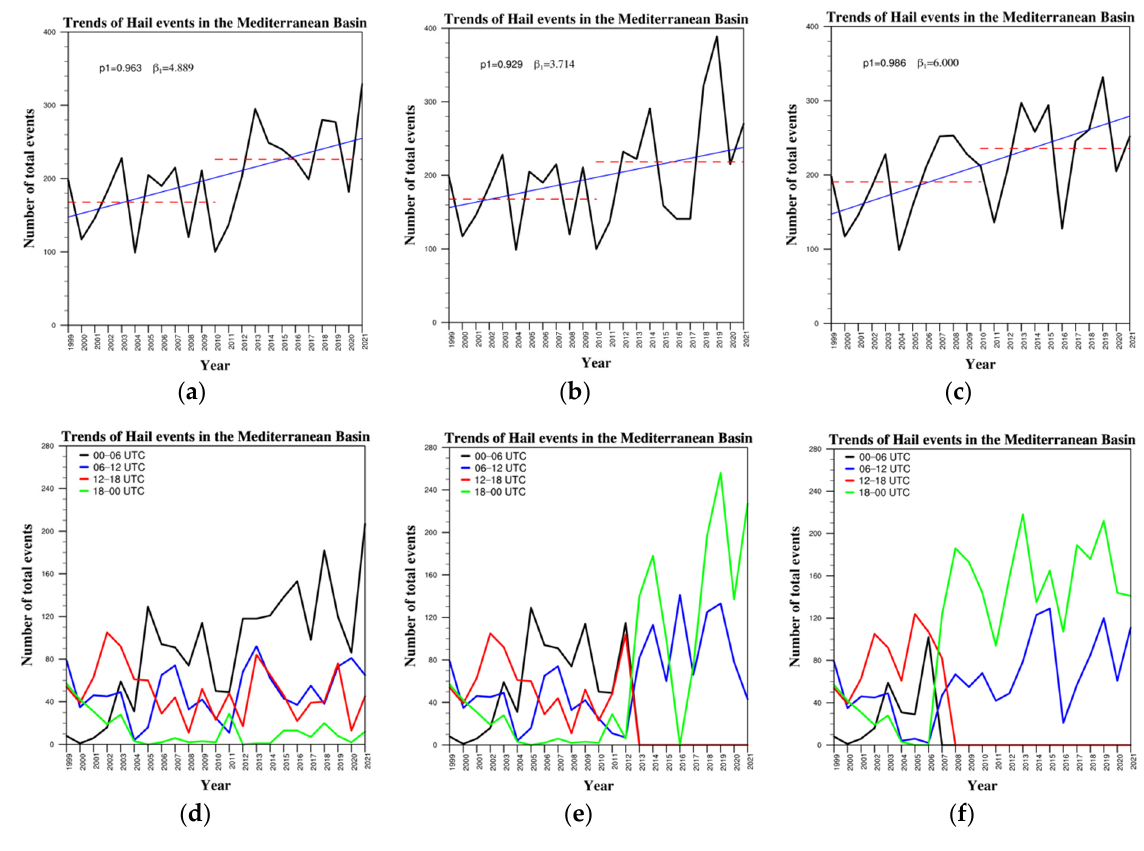
Figure 7. Temporal evolution of the annual number of H events for the entire Mediterranean basin considering the three-time series according to Table 2, i.e., time series-1 N15-N18-NPP ( a , d ), time series-2 N15-N18-MOB ( b , e ), and time series-3 N15-MOA-MOC ( c , f ). In ( a – c ) p1 and 𝛽 1 represent the confidence level and the trend rate (number of H events/year), respectively; red dashed lines identify the mean values of the number of H events in the two analyzed decades; blue line is the linear trend. Colored curves in ( d – f ) present the evolution of the annual number of H event in four temporal windows, i.e., 00–06, 06–12, 12–18, and 18–00 UTC.